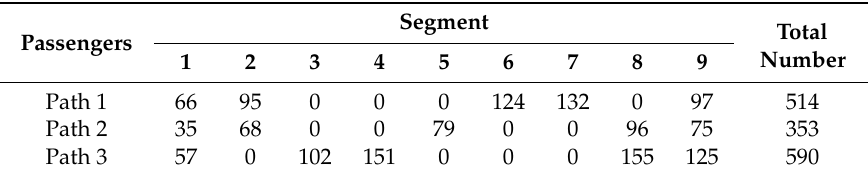
Table 5. The passenger assignment of each segment for three paths based on a SUE (accumulative total